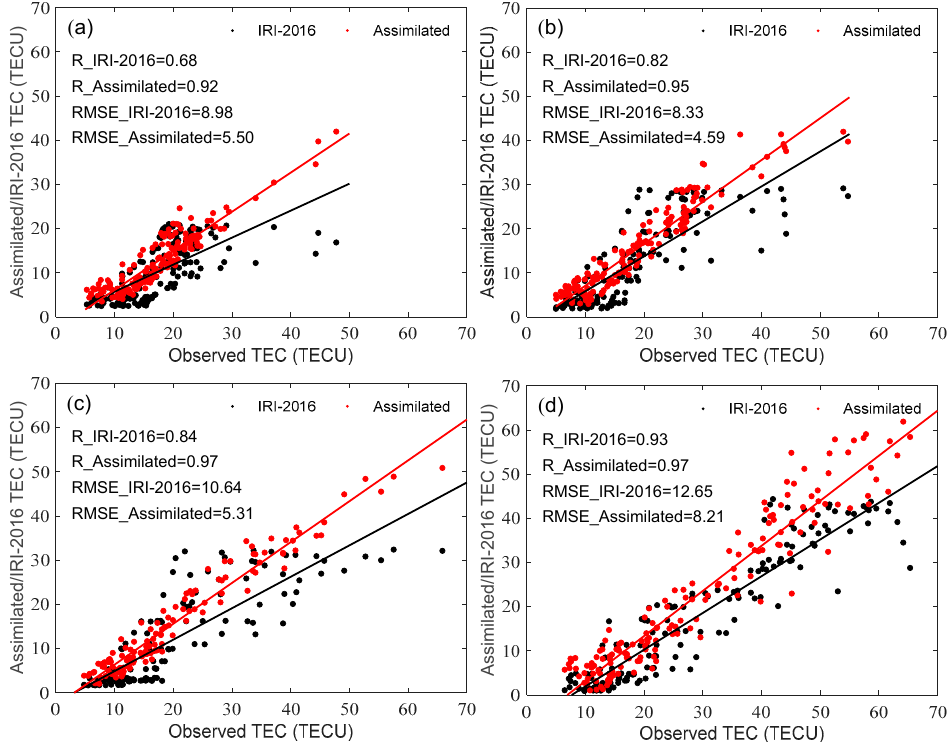
Figure 10. Assimilated and IRI-2016 TEC distributions versus the GNSS-observed TEC of different stations for a 7-day period from 5 September 2017 to 11 September 2017. ( a ) GAMG; ( b ) JFNG; ( c ) LHAZ; ( d ) CMUM.